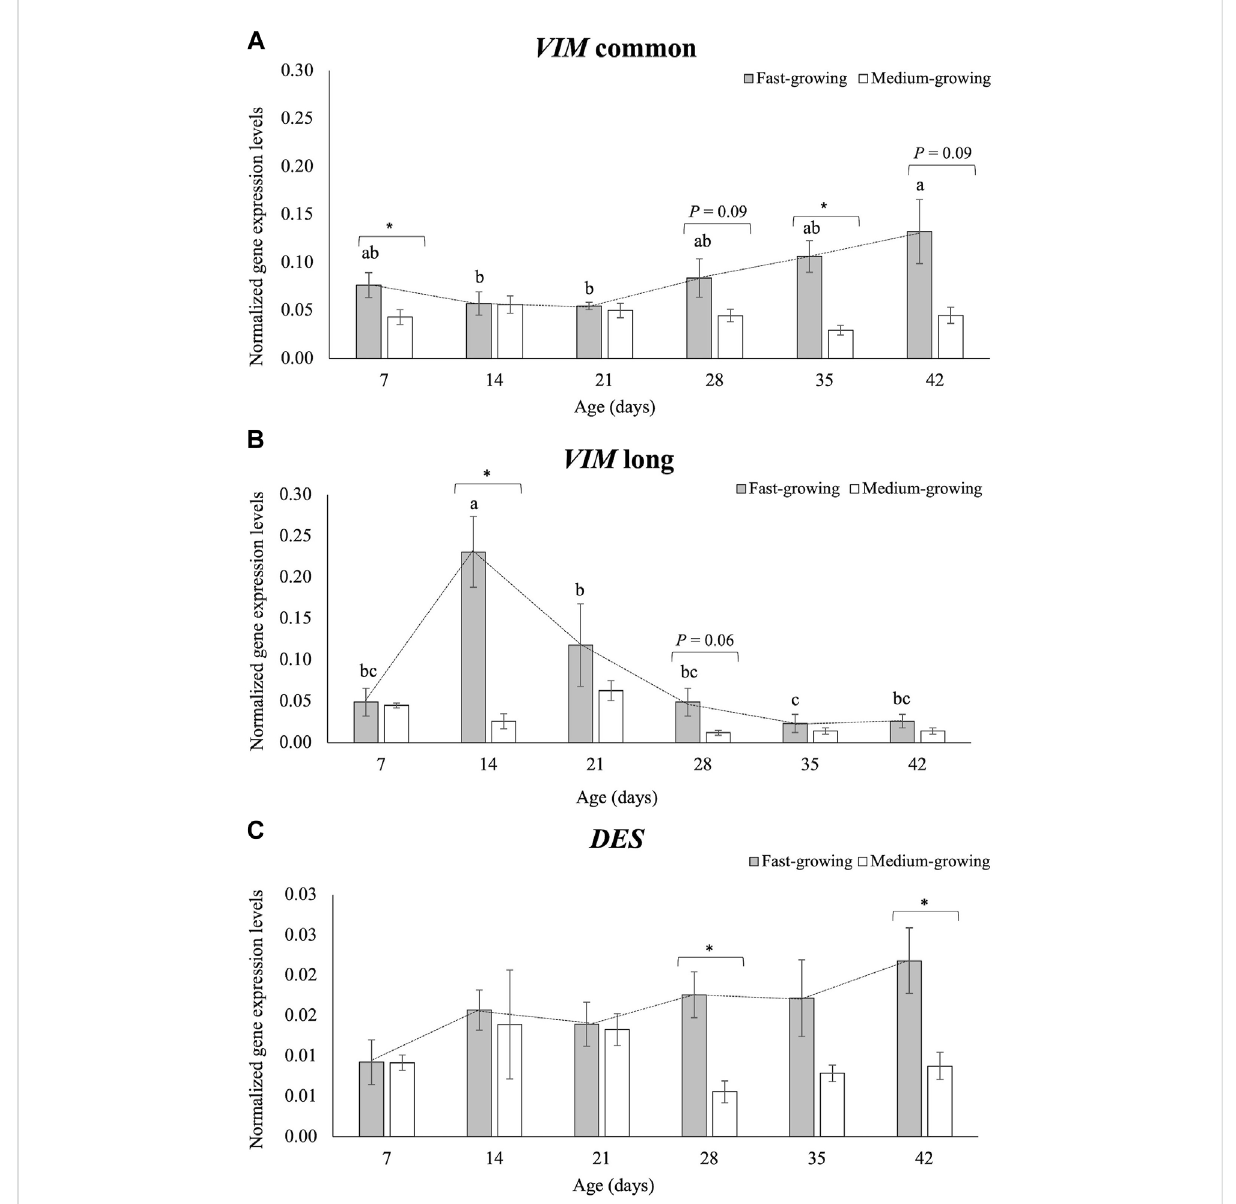
FIGURE 6 The normalized expression values of the Vimentin ( VIM ) common sequence (A) , Vimentin ( VIM ) long-isoform (B) , and Desmin ( DES ) gene (C) in Pectoralis major muscles of broilers belonging to a fast- and medium-growing genotype at different ages (7, 14, 21, 28, 35, and 42 days). For each panel (A,B,C) ,thebargraphsshowthemeanvaluesofthenormalizedexpressionlevelforeachgenotype(FGandMG)ateachsamplingtime,andthe errorbarsindicatethemeasuredstandarddeviations.Signi fi cantdifferencesbetweenFGandMGateachsamplingtimewereanalyzedbyusing the non-parametric Mann-Whitney U. The signi fi cant p -values ( p ≤ 0.05; *) and trends towards signi fi cance ( p ≤ 0.10) are reported for the comparisons betweenFGandMGwithineachsamplingage.Ontheotherhand,thelinegraphevidencestheevolutionofthenormalizedexpression levelofeachgeneduring thetimeinFGbroilers.Theevolutionofthenormalizedgeneexpressionof VIM commonsequence, VIM long-isoformand DES geneinFGovertheirgrowth periodwasassessedbyOne-wayANOVA. a-c=forFG,meanvaluesfollowed bydifferentletterssigni fi cantlydiffer over the growth period ( p ≤